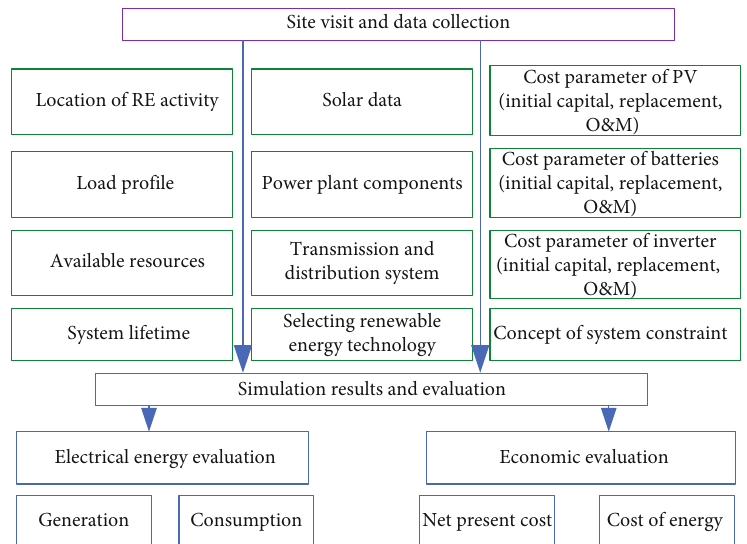
Figure 1: Illustration of the framework for analysis of the study. Abbreviations: RE: renewable energy; O&M: operation and maintenance.